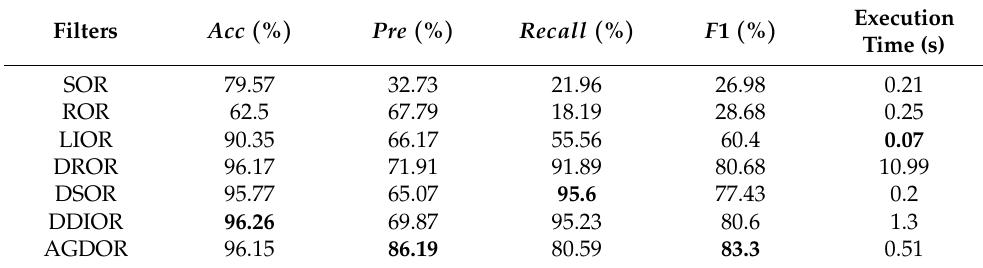
Table 2. Comparison of the proposed